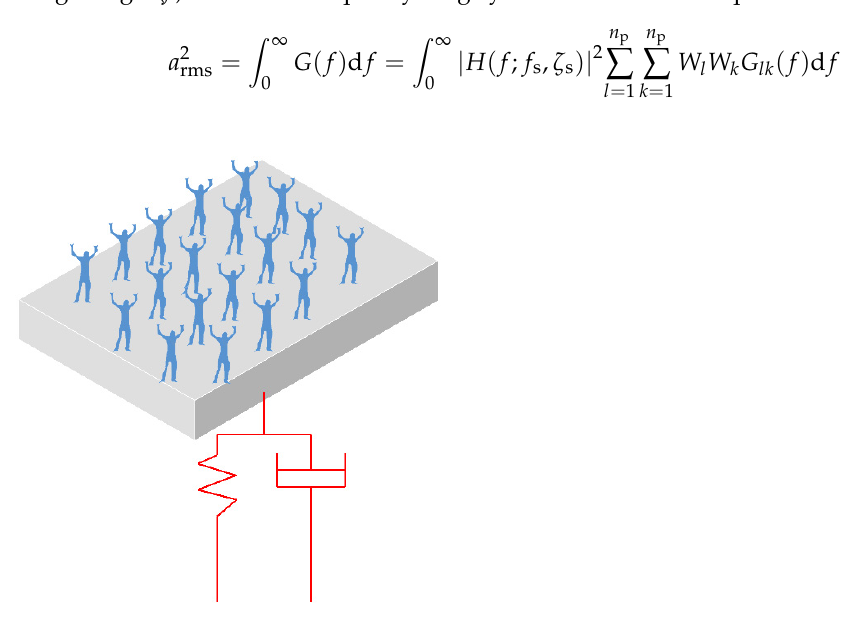
Figure 2. Model of single degree-of-freedom system subjected crowd jumping loads.